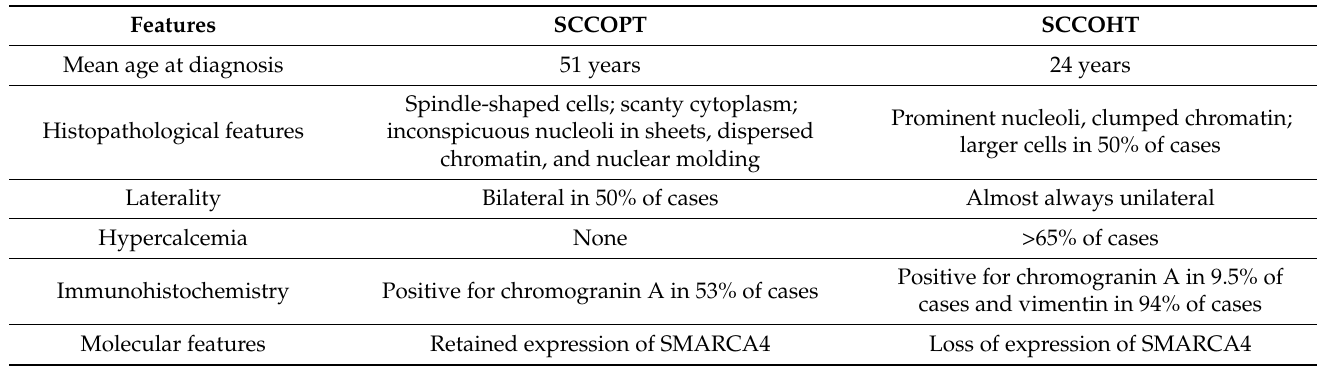
Table 8. Differentiating features between ovarian small cell carcinoma of pulmonary and